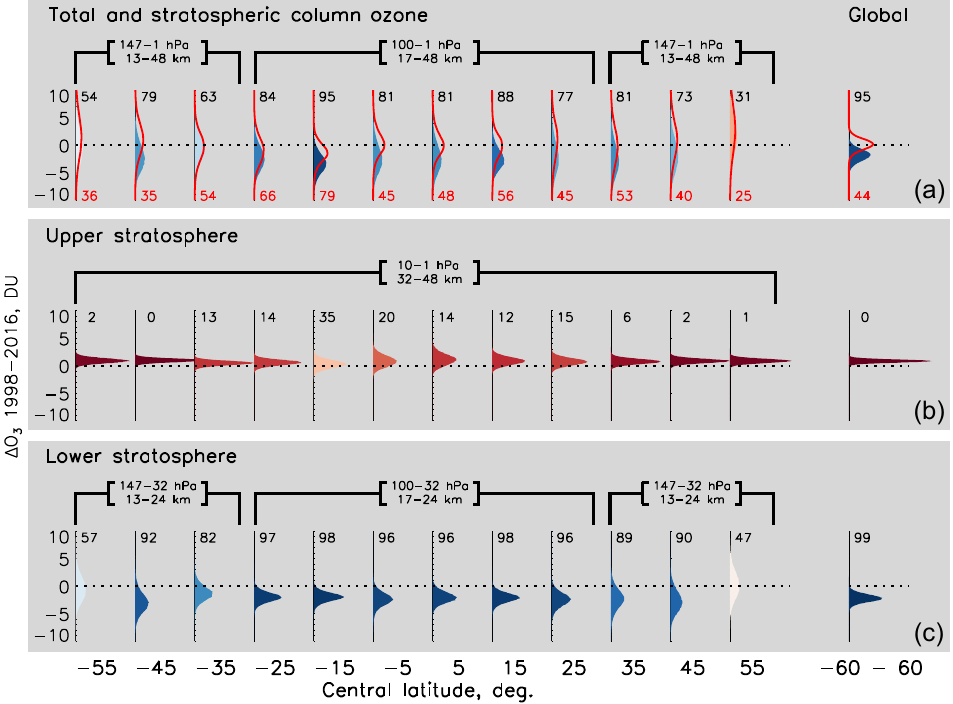
Figure 2. Merged-SWOOSH/GOZCARDS posterior distributions (shaded) for the 1998–2016 total and partial column ozone changes. (a) Whole stratospheric column and (b) upper and (c) lower stratosphere in 10 ◦ bands for all latitudes (left) and integrated from 60 ◦ S to 60 ◦ N (“Global”, right). The stratosphere extends deeper at mid-latitudes than equatorial latitudes (marked above each latitude). Numbers above each distribution represent the distribution percentage that is negative; colours are graded relative to the percentage distribution (positive, red-hues, with values < 50; negative, blue). SBUV total column ozone (red curves) is given in the upper row and negative distribution percentages are given as red